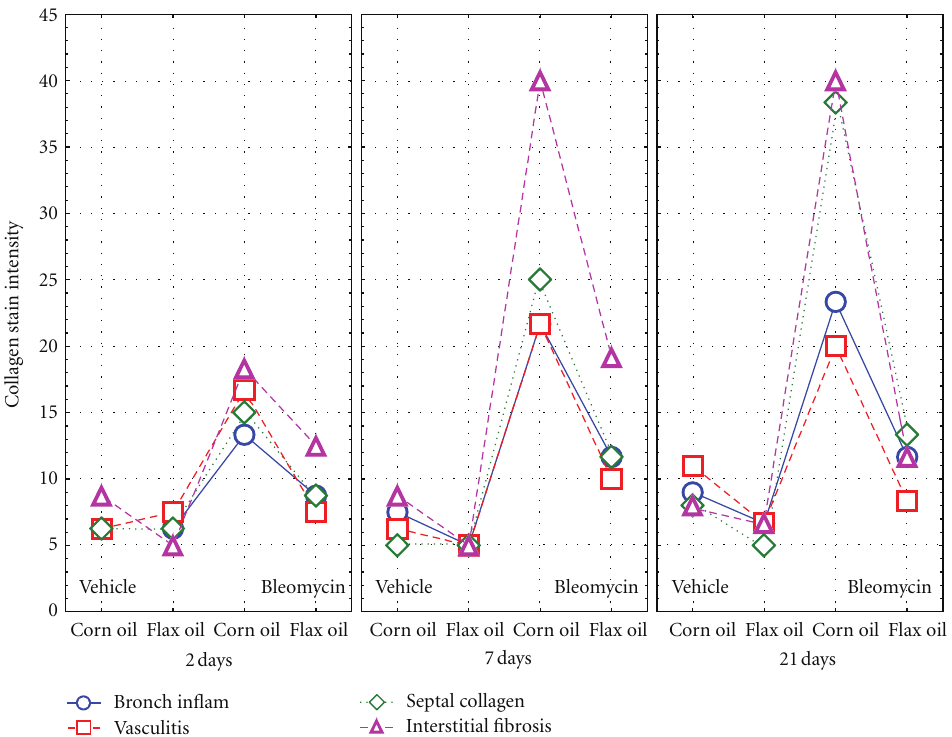
Figure 2: Qualitative evaluation of the pathological scores of the various treatment groups at each time interval point. (Staining: Masson’s trichrome). The symbols represent the mean of all the rats in each group. Scoring of pathology: Ranges from 5: borderline damage, progressing to a high of 40: very severe and extensive damage. Scoring of stain intensity: estimated area of blue stain on a series of high- power fields with trichrome staining. Abbreviations: Bronch. Inflam.: Bronchial Inflammation with loss of epithelium, loss of cilia, and increased number of inflammatory cells. Vasculitis: Thickening of the media of vessels and reduction of lumen patency. Septal collagen: Presence of blue stained fibers on trichrome stain. Interstitial fibrosis: Presence of fibers in the septa stained by